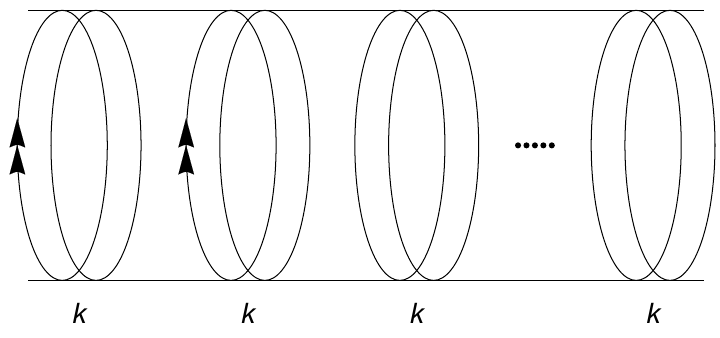
‘multiwound’ copies k